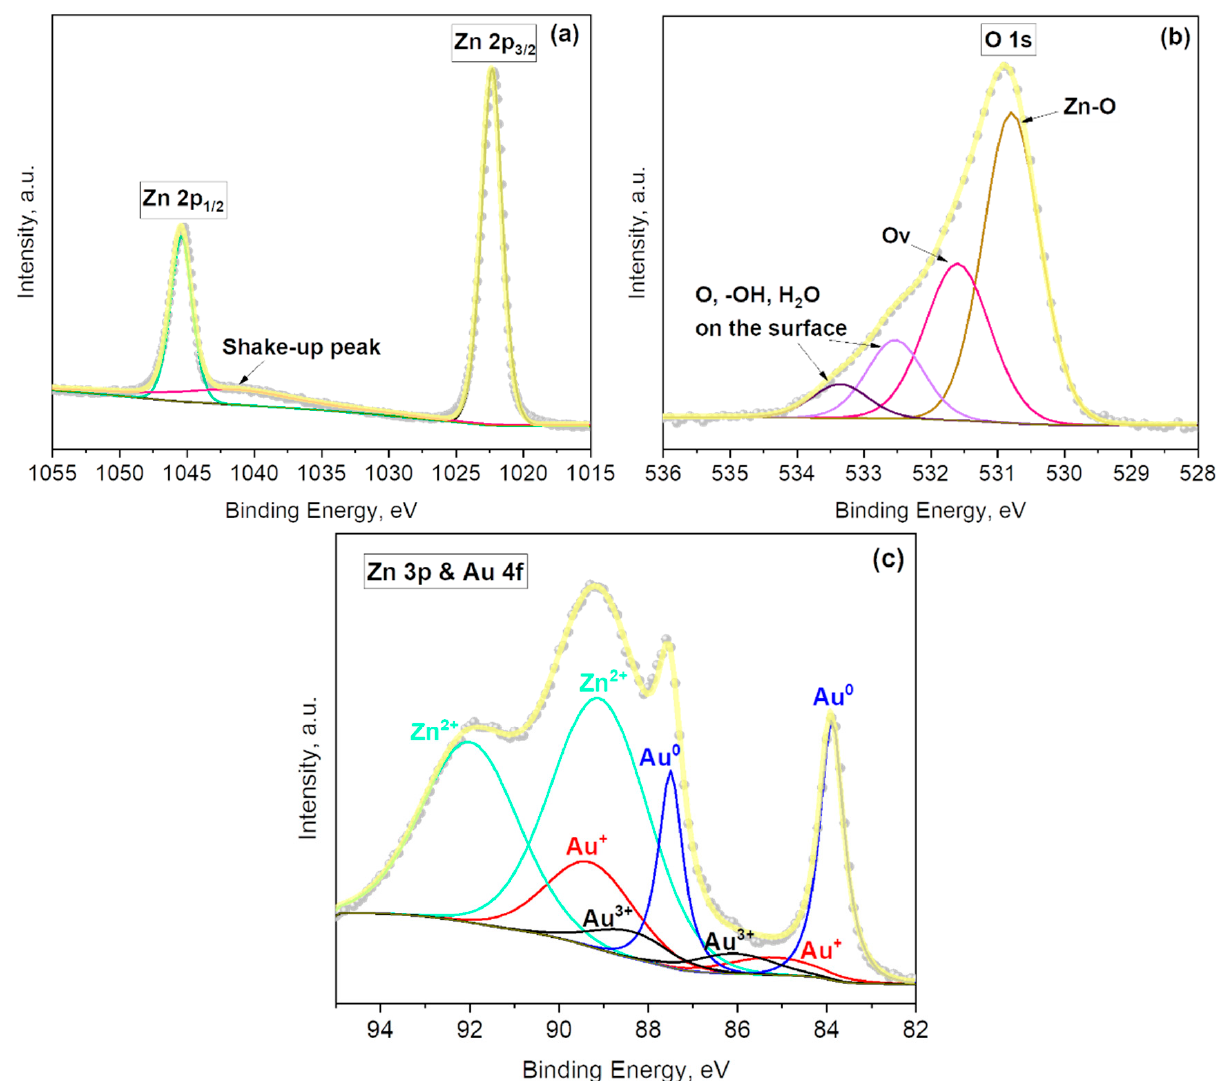
Figure 3. ( a ) Zn 2p, ( b ) O 1s, and ( c ) Au 4f and Zn 3p core-levels XPS spectra recorded on the Au@ZnO films. Grey dots represent the raw data, the solid yellow line corresponds to the envelope/fitting curve, and the other colored curves to the deconvoluted components.